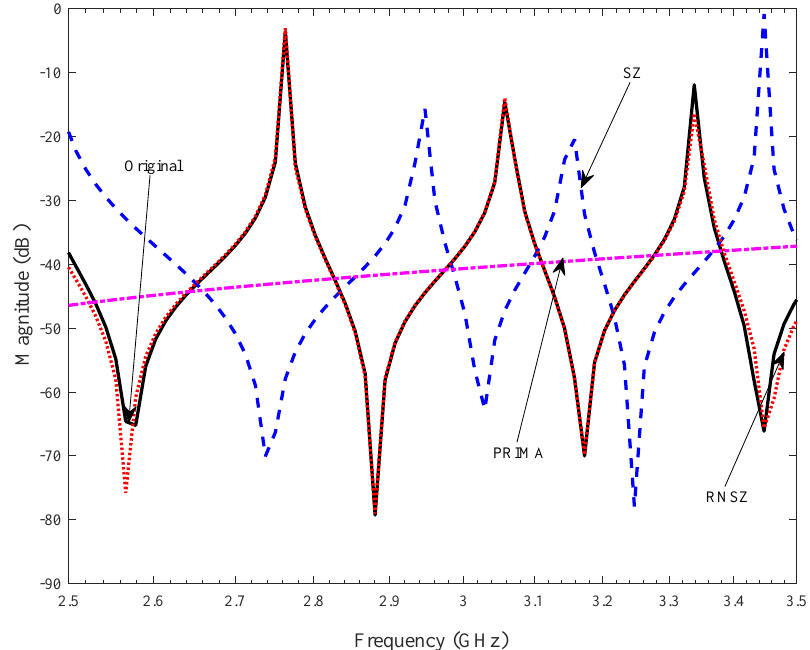
Figure 4. Magnitude response of the frequency of interest, i.e., operating frequency range of i7-2920XM from 2.5 GHz to 3.5 GHz. The proposed RNSZ method closely matches with the original